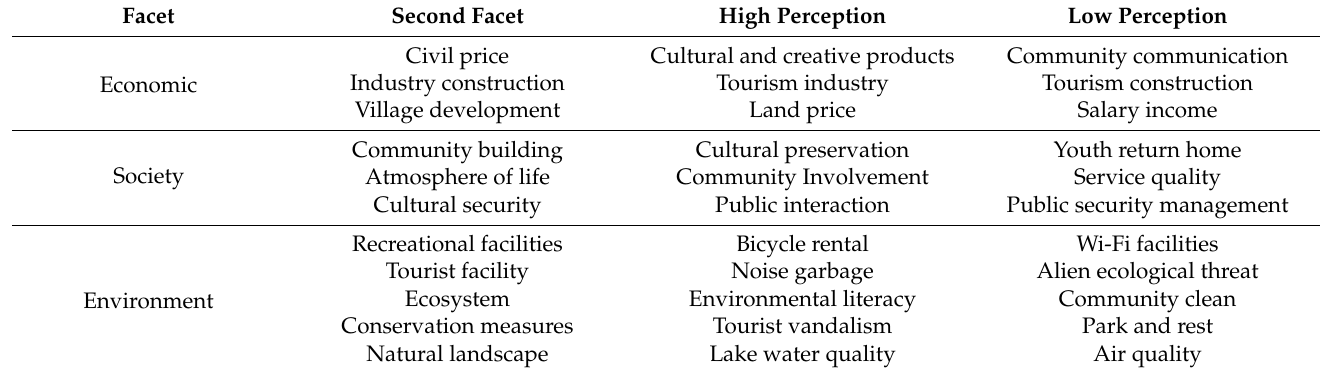
Table 3. Cognitive analysis of tourist rural